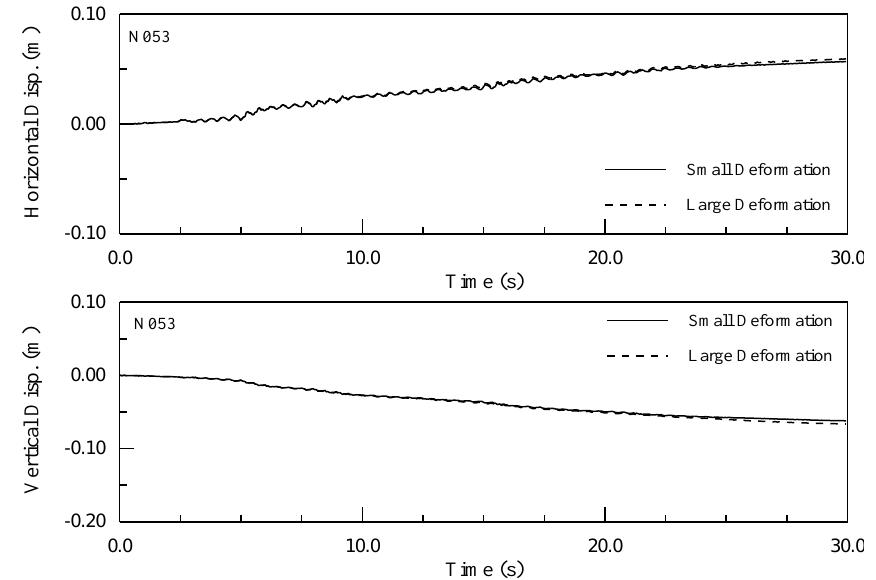
Figure 8. Horizontal and vertical displacement – time histories at node N053.